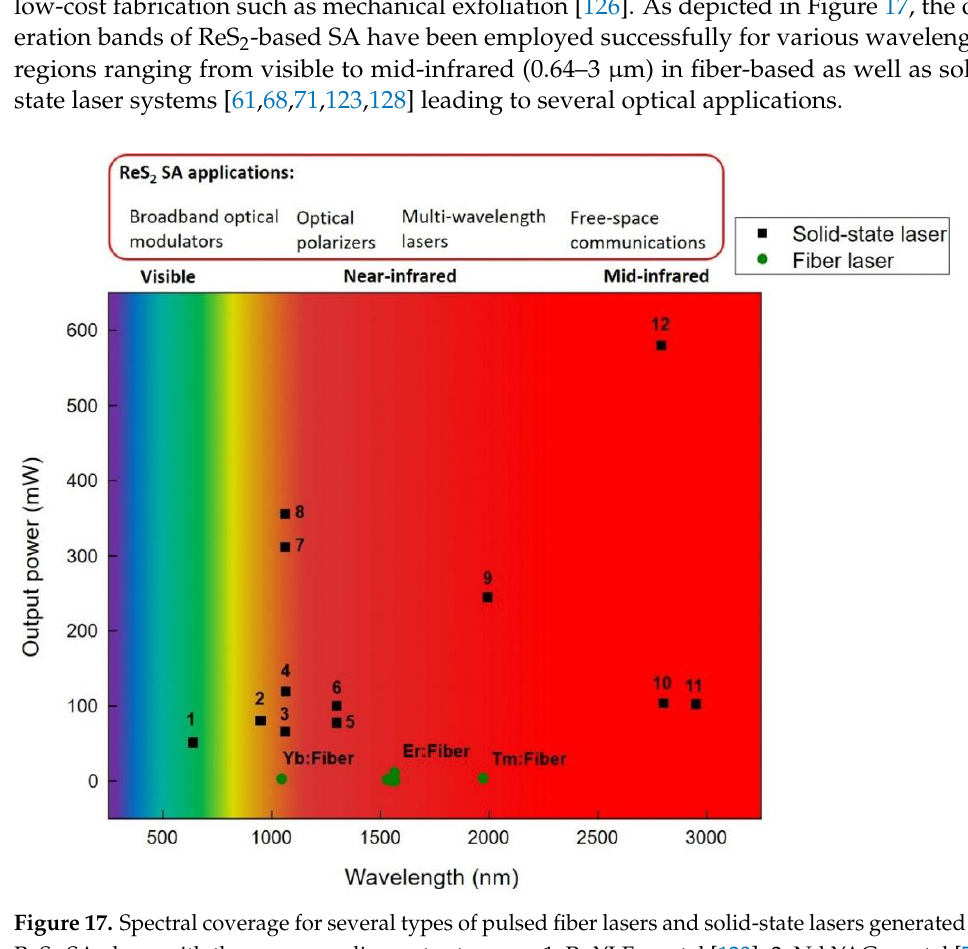
The bandgap of ReS 2 amounts to ~1.4 eV which corresponds to an optical absorption at ~800 nm wavelength [130]. Nonetheless, previous works have reported generation of Q-switched and mode-locked lasers using ReS 2 functioning as SA at 1550 nm (~0.8 eV) and 2950 nm (~0.4 eV), which is much less than the bandgap of ReS 2 . Thus, in theory, there ought to be no light absorption. Nonetheless, the absorption occurs due to the unavoida-